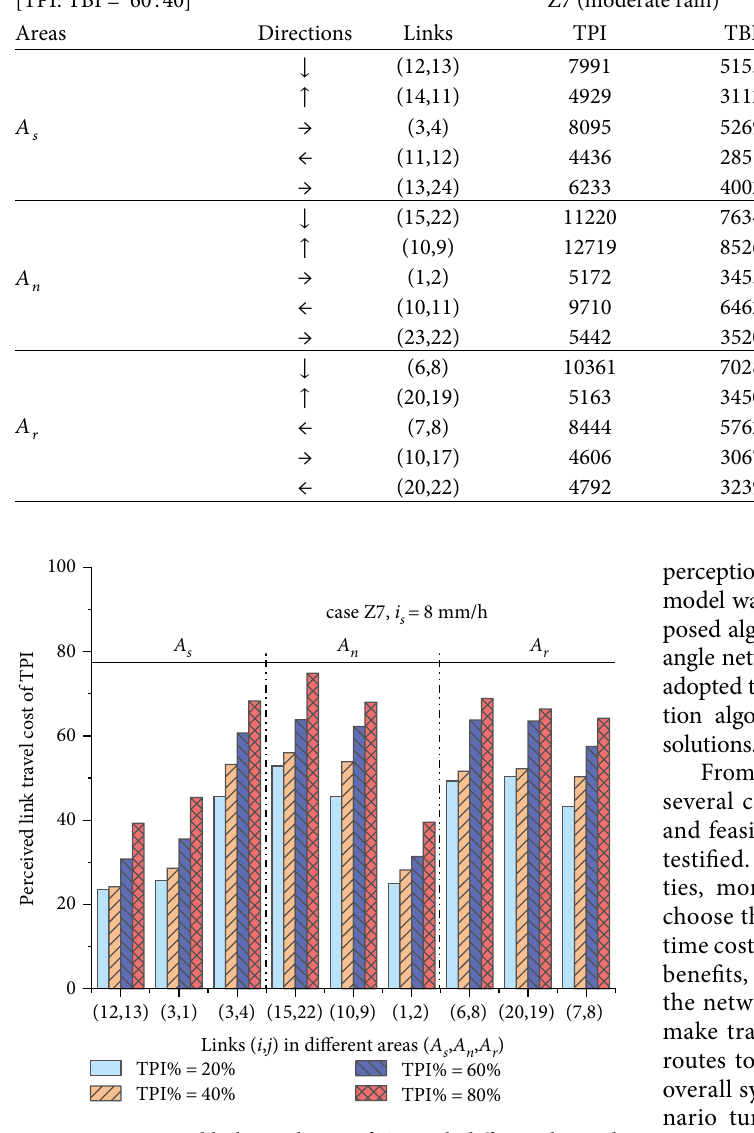
Figure 10: Perceived link travel time of TPI with different demand share in the